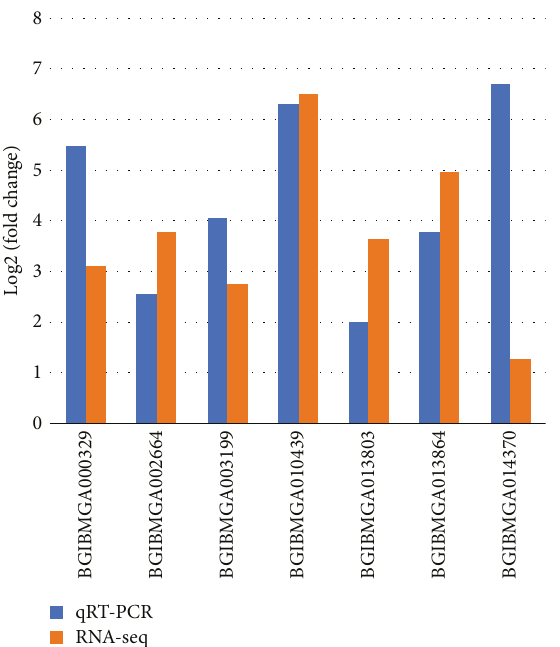
Figure 3: Real-time quantitative PCR results of